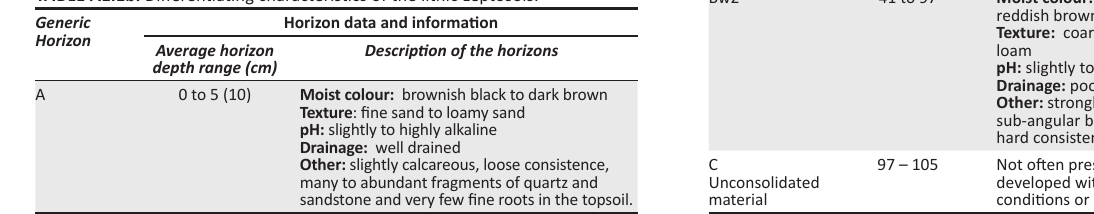
TABLE A1.1b: Differentiating characteristics of the lithic Leptosols.